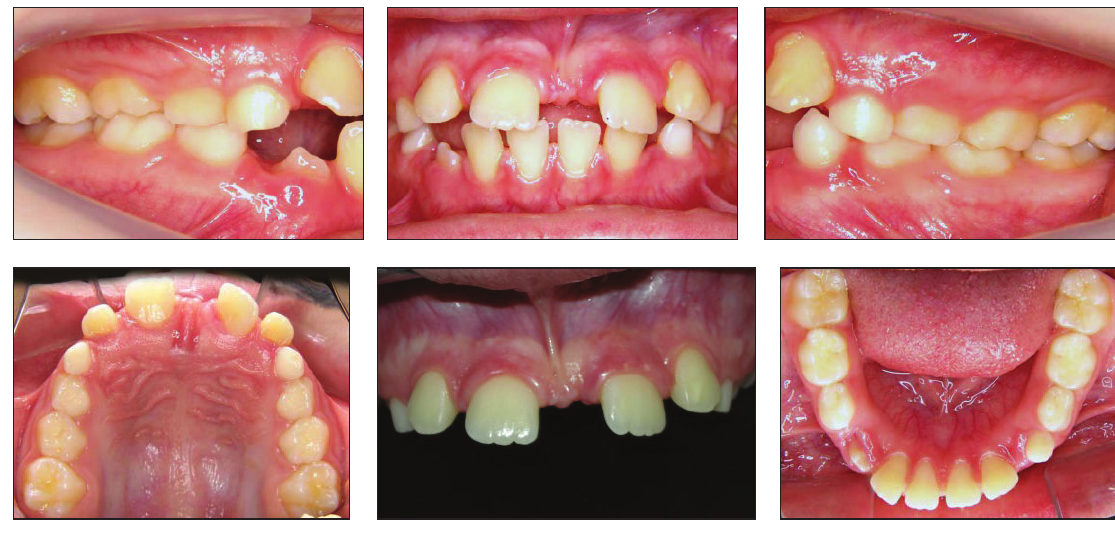
Figure 1: Pretreatment intraoral photographs.